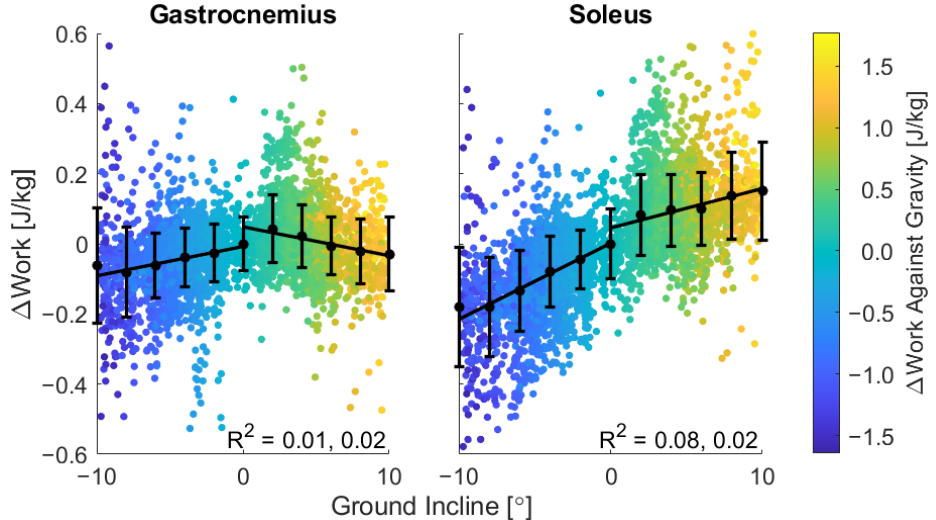
Figure 7. For each of 4777 strides from 11 participants, change in net work relative to participant- specific mean net work in the level walking strides. Linear regressions performed separately for negative and positive slopes illustrate differing trends in gastrocnemius vs. soleus muscle function.